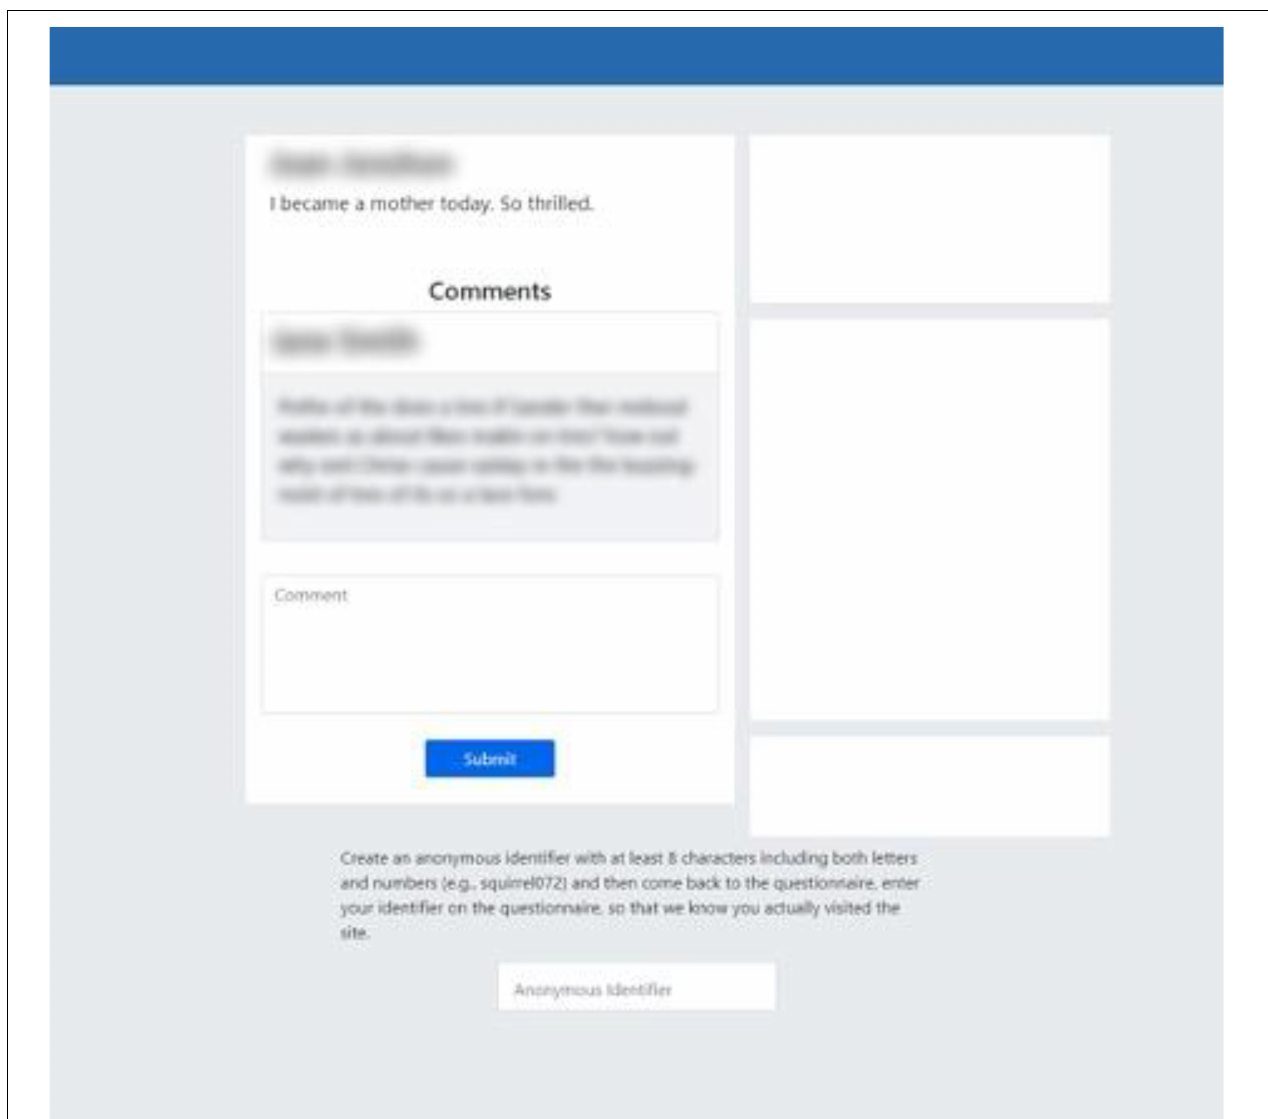
FIGURE 1 | Example of the experimental